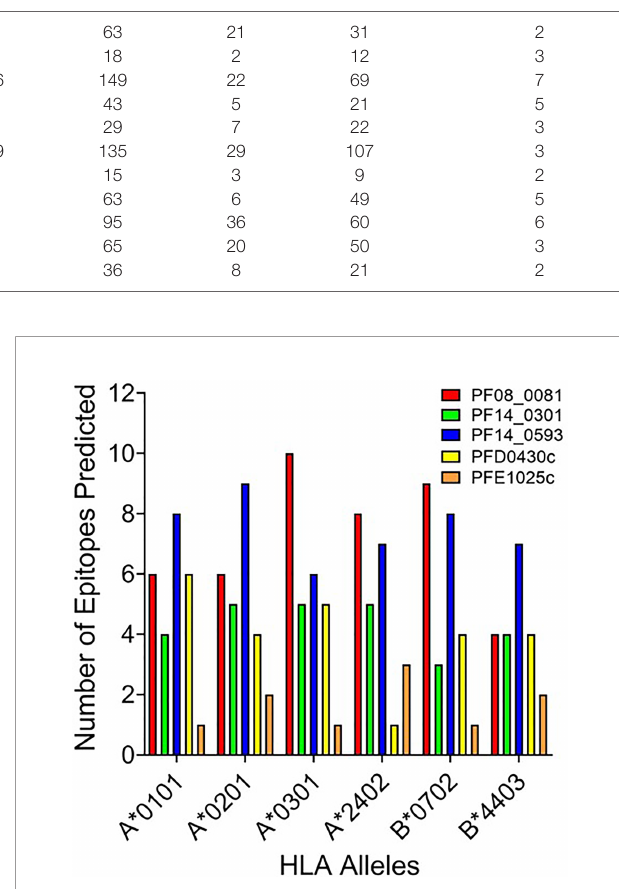
FIGURE 2 | The number of predicted epitopes for each HLA allele supertype from each of the fi ve proteins. Shown are the number of peptides predicted by EpiMatrix to bind a speci fi c class I HLA allele and selected for further